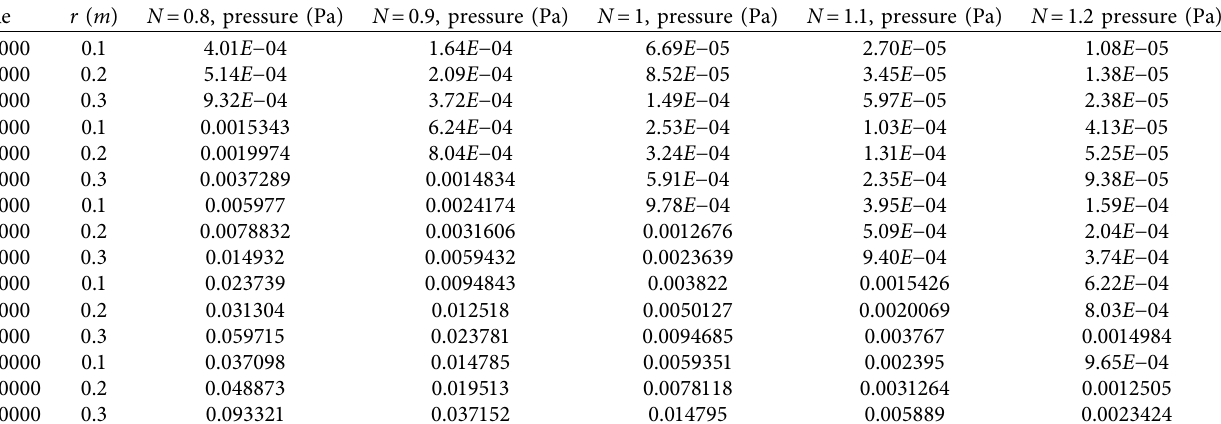
Table 2: Numerical values of maximum pressure over the surface of heated cylinder under different